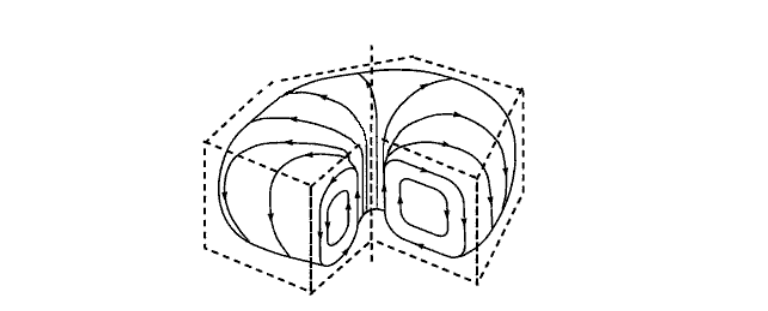
Figure 1: Sketch of an overturning hexagonal (dashed lines) convective cell with vertical extent ℓ . Near the centre the gas raises from the hot bottom to the cooler top (surface) where it moves nearly horizontally towards the edges, thereby loosing heat. The cooled gas then descends along the edges to close the circular flow. Arrows indicate the direction of the flow pattern. Image adapted from Swenson